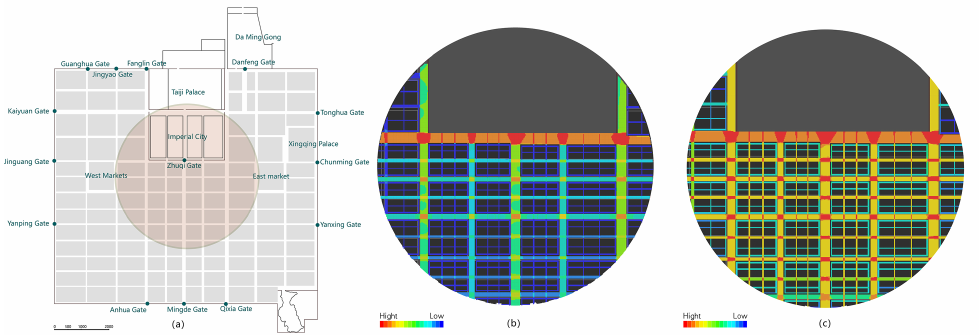
Figure 17. ( a ) Recovery plan of Chang’an of the Tang Dynasty, ( b ) the visual integration value of Zhuque Avenue and ( c ) the isovist connectivity value of Zhuque